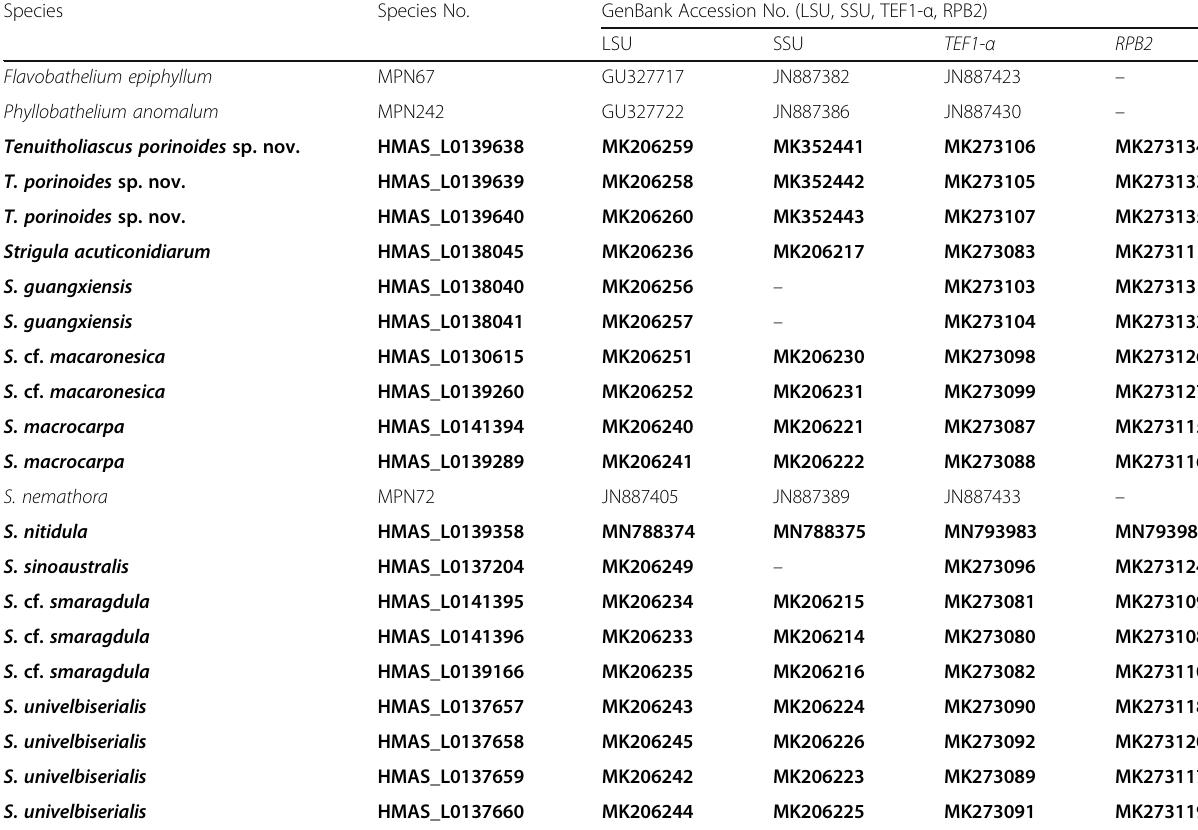
Table 1 Sequences for molecular phylogenetic analysis in Strigulales . The new sequences generated were in bold Species Species